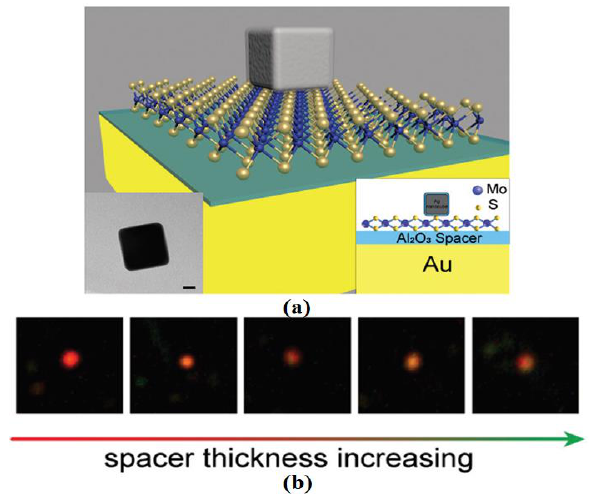
Figure 17. ( a ) 3D illustration of NCoM cavity encapsulating monolayer MoS 2 flakes. ( b ) Tunability of plasmonic cavity resonance in NCoM systems [97]. plasmonic cavity resonance in NCoM systems